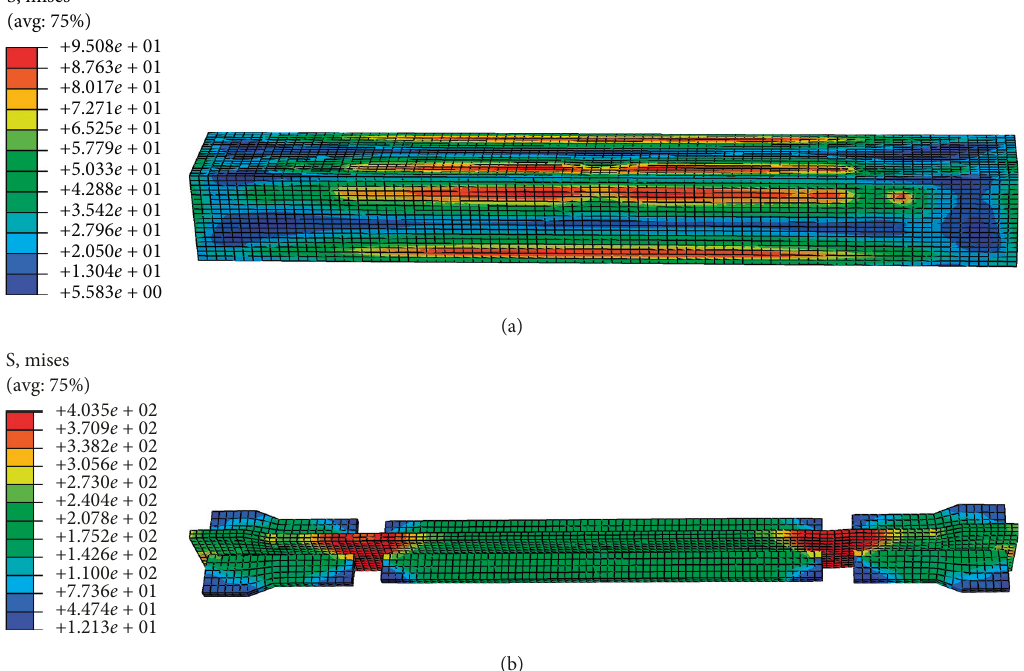
Figure 14: Mises stress contours of the specimen. (a) Restraining tube ( σ